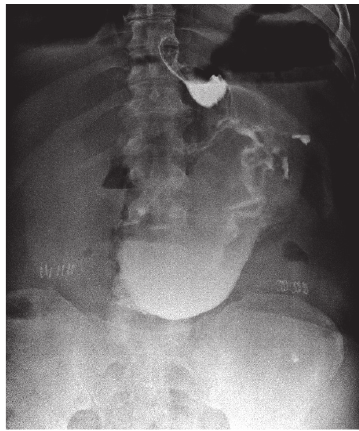
Figure 1: Male, 48 years, BMI 43 Kg/m 2 . Evidence of leakage at radiological upper gastrointestinal